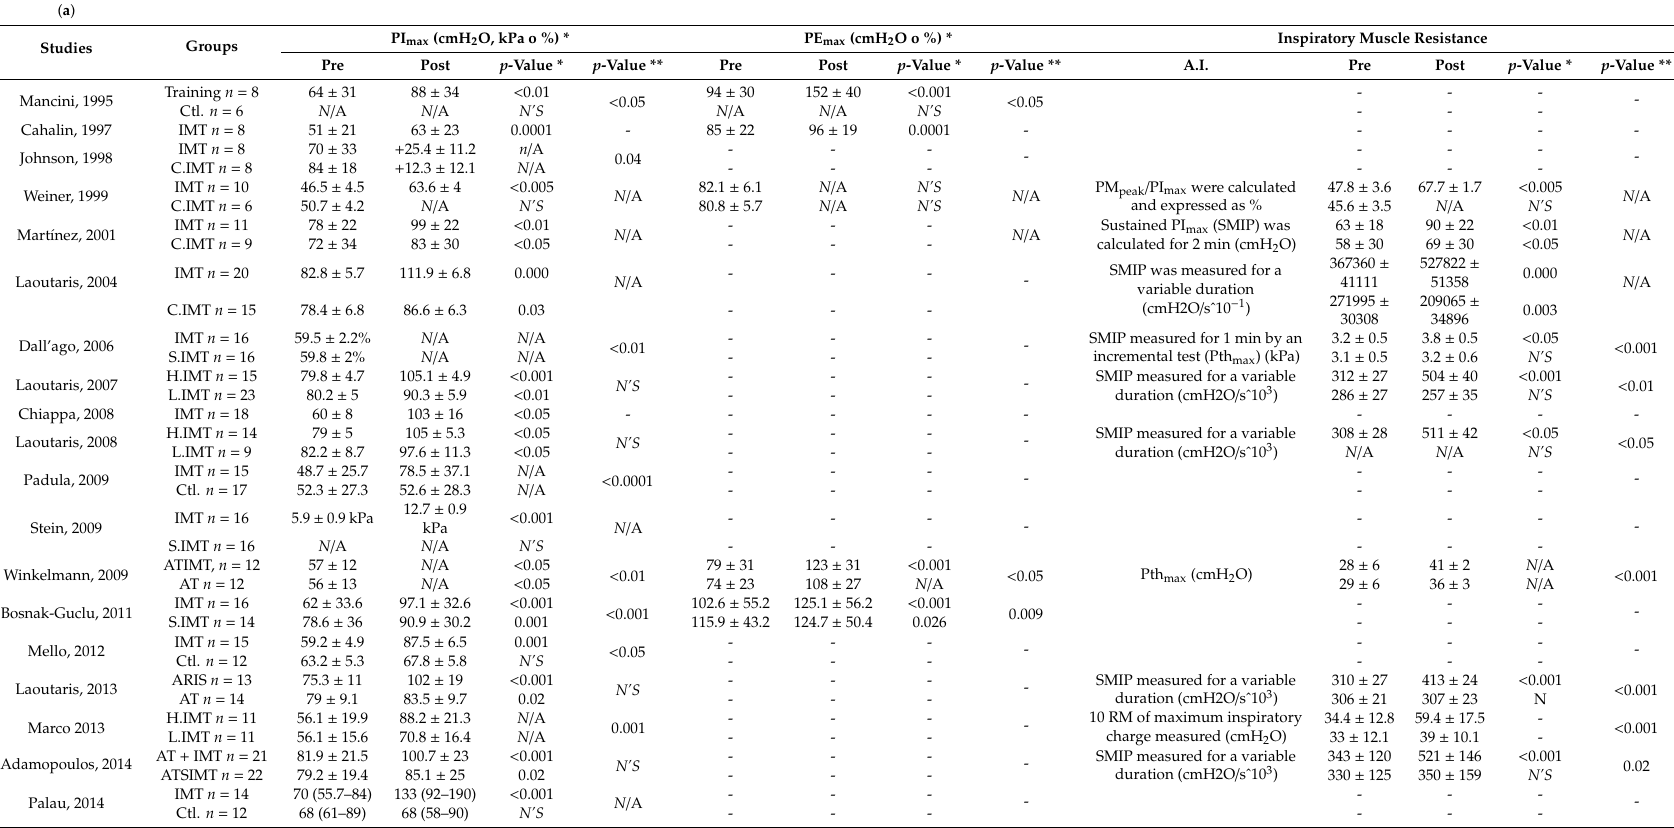
Table 2. a. Inspiratory muscle strength and resistance; b. Lung